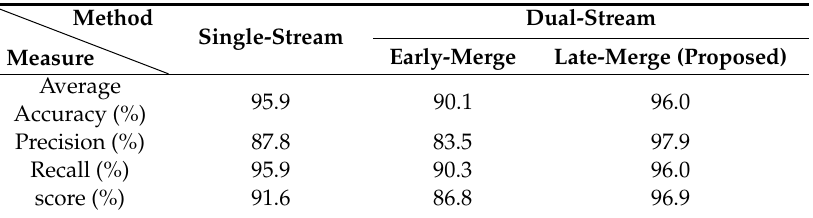
Table 3. Performance of classification for CNN